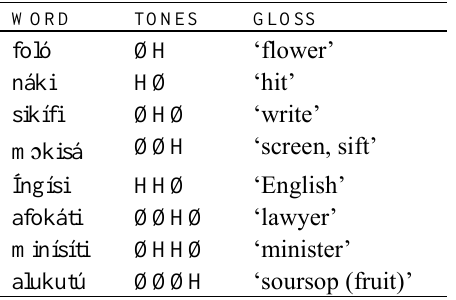
Table IV: Common patterns of words with unspecified